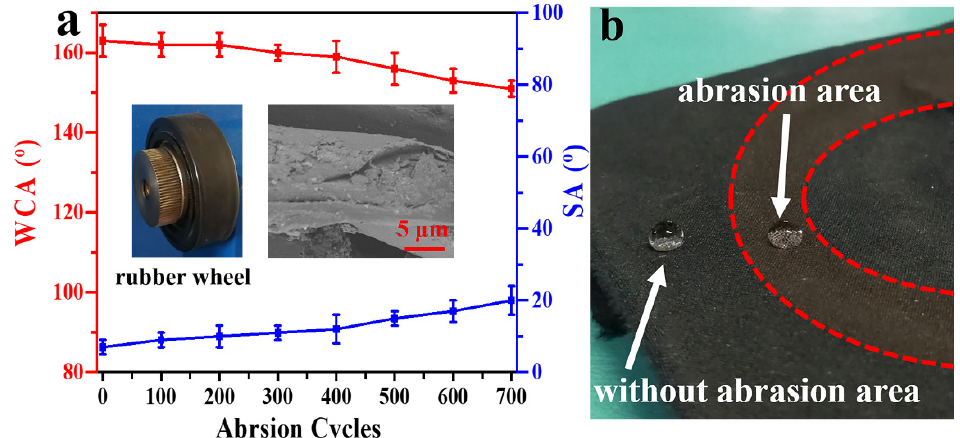
Figure 8. ( a ) Changes in the WCAs and SAs of the PDMS/STA/SiO 2 -coated fabric with wear condition. (The insets are an SEM image after 700 wear cycles and a photograph of the rubber wheel wear instrument). ( b ) Shapes of water droplets on the PDMS/STA/SiO 2 -coated fabric with and without the abrasion area.